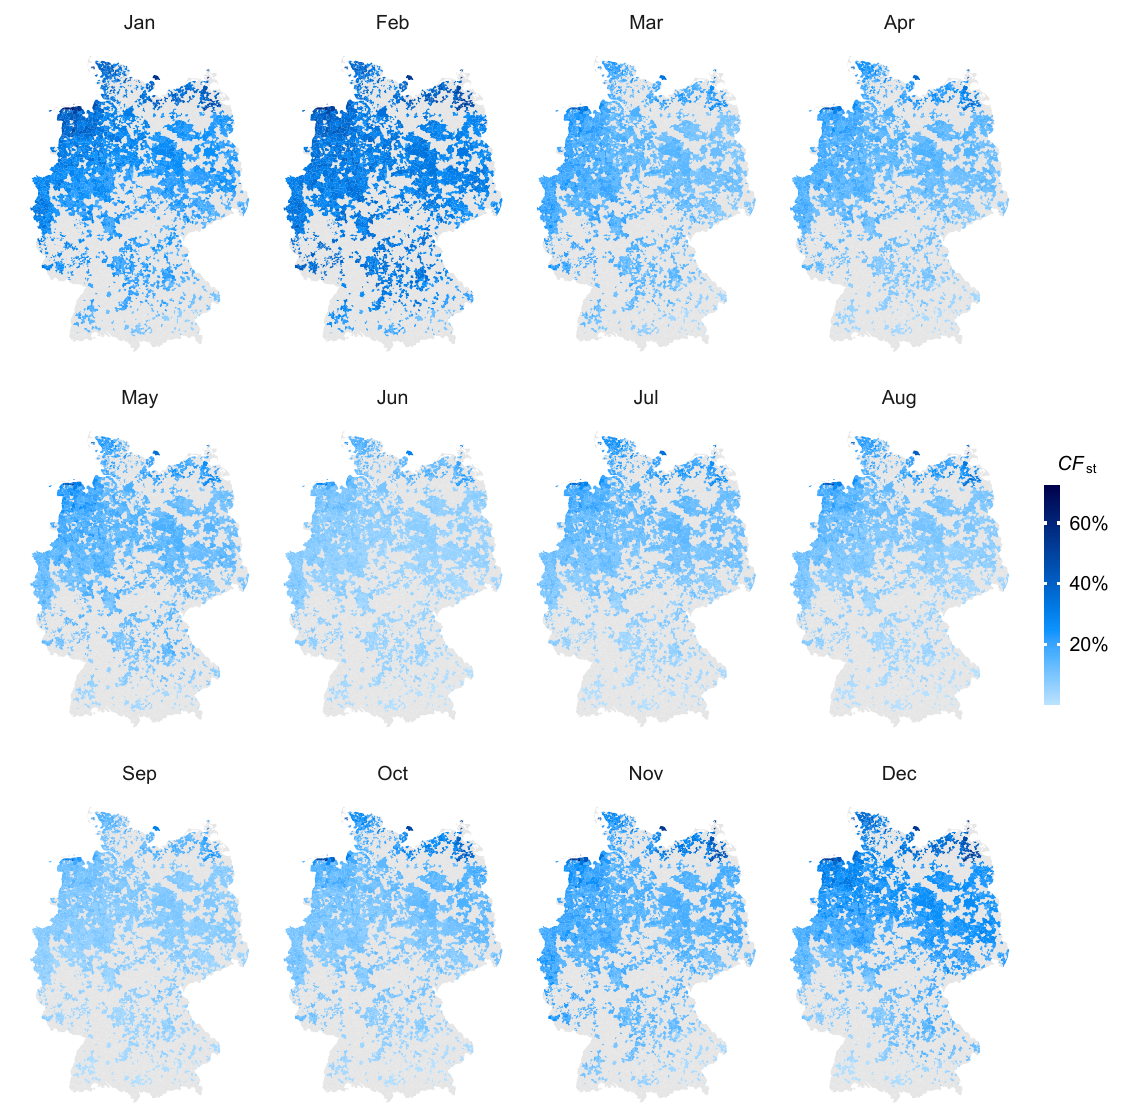
Figure 11. Determined monthly capacity factors of wind turbines at LAU2 level in Germany for 2016. In the grey areas no wind turbines are installed.